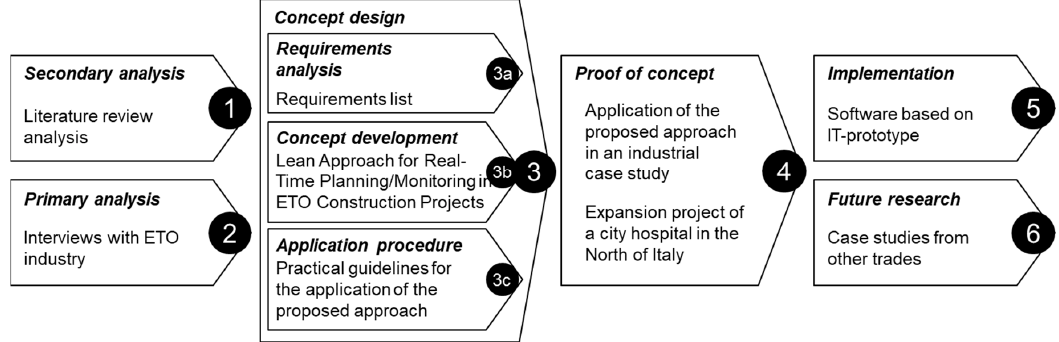
Figure 1. Phase model of the applied research approach.